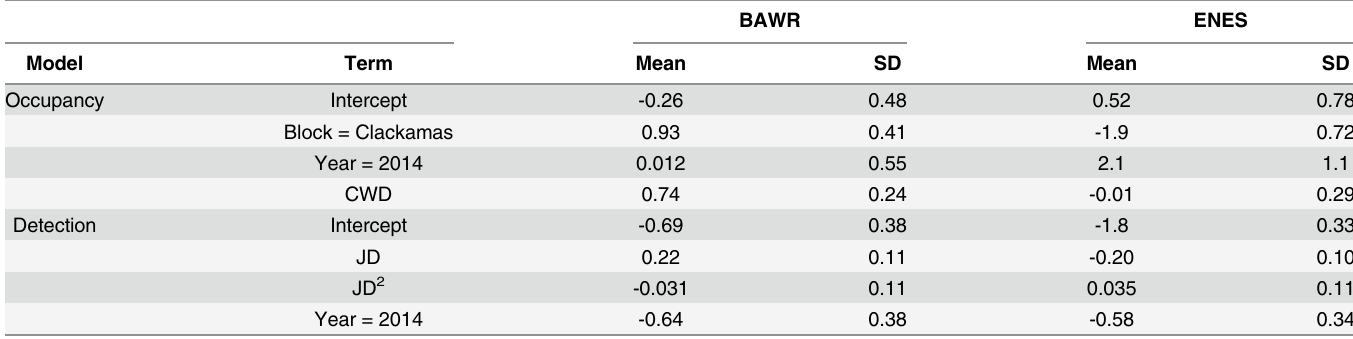
Fig 8. Average, by combination of parameters, of all posterior mean estimates of the treatment effect estimator ‘ Alpha3 ’ (see Eq 2) in the multi- scale occupancy model under a relaxed set of priors. Note we ran only a subset of cases in Table 1 for this analysis. Results are shown on the logit scale. Panels show the results for different combinations by simulated detection probability and post-treatment occupancy. Horizontal dashed lines show the true coefficient value. Prior sensitivity can be assessed by comparing with Fig 2. doi:10.1371/journal.pone.0142903.g008 Table 3. Posterior estimates of model parameters and standard deviations (SD) for both Oregon slender (BAWR) and ensatina (ENES) salaman- ders, Oregon Cascades, USA, 2013 – 2014. All estimates are reported on the logit scale to two significant digits. Estimates for coarse woody debris (CWD) and Julian date (JD) are based on standardized